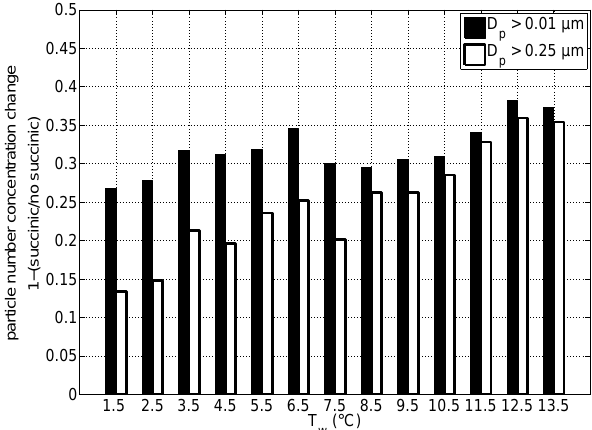
Fig. 7. Change of median particle number concentrations between particle number concentrations after adding succinic acid and be- fore adding succinic acid as a function of water temperature ( T w